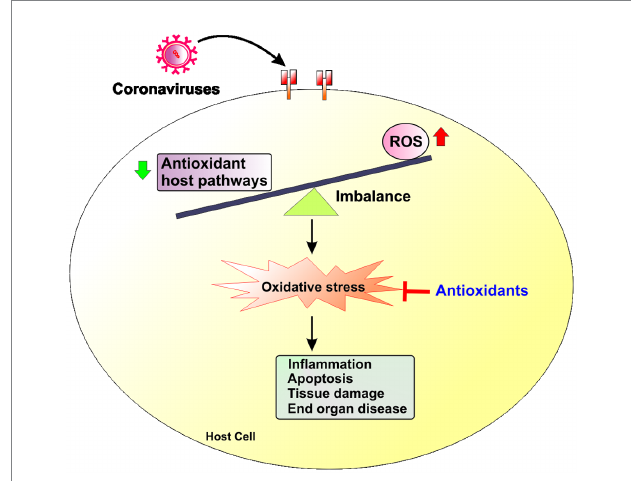
FIGURE 1 Redox imbalance in coronavirus infections. Coronavirus infection triggers an imbalance between increased production of reactive oxygen species (ROS) and reduced antioxidant host responses that leads to increased redox stress in the host cell. Increased redox stress induces inflammation, apoptosis and ultimately tissue damage and end organ